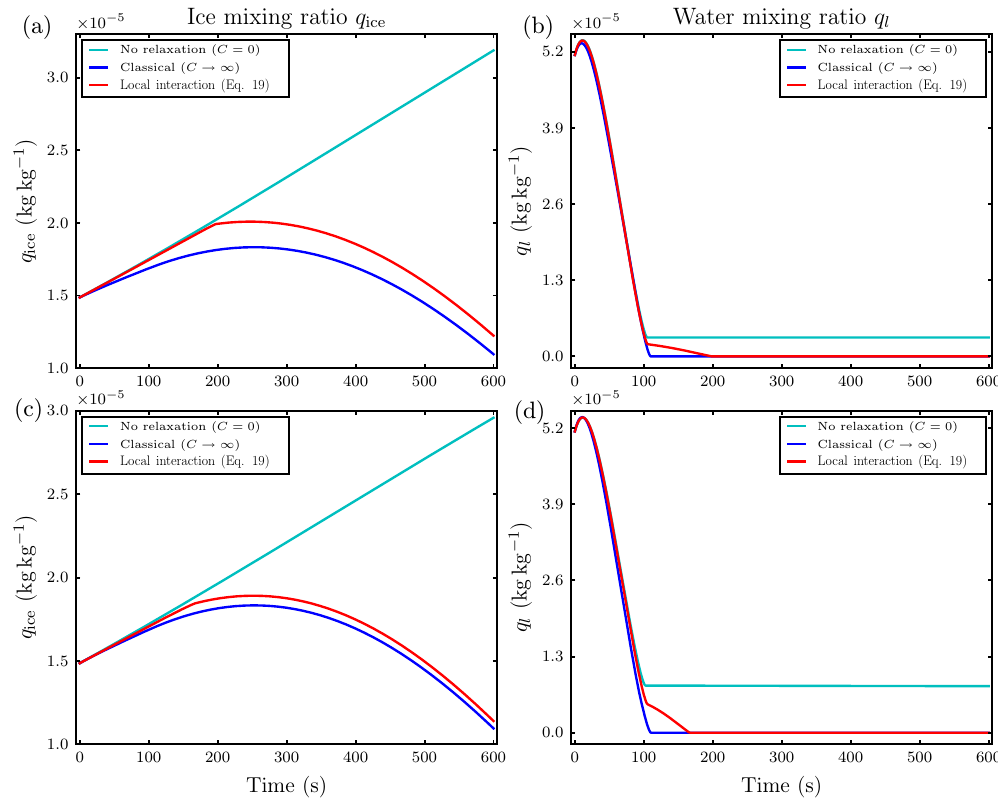
Figure 8. Temporal evolution of the ice mixing ratio in panels (a) and (c) and the liquid water mixing ratio in panels (b) and (d) for the parcel model simulations with w = − 1ms − 1 at initial ambient saturation ratio S ∞ = 1 . 01. Panels (a) and (b) show the case with N d = 200 droplets in each influence sphere of the ice crystals and droplet distance l 0 = 5 R i . Panels (c) and (d) show the case with N d = 500 and droplet distance l 0 = 30 R i . Note the different scaling of the